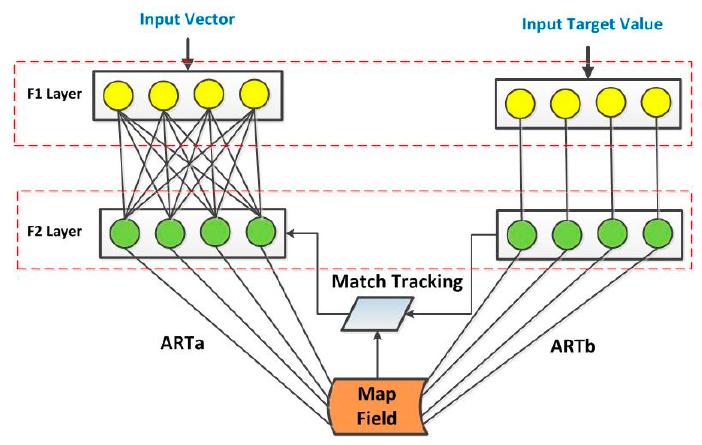
Figure 2. General diagram for the Fuzzy ARTMAP Network (FAN) network.